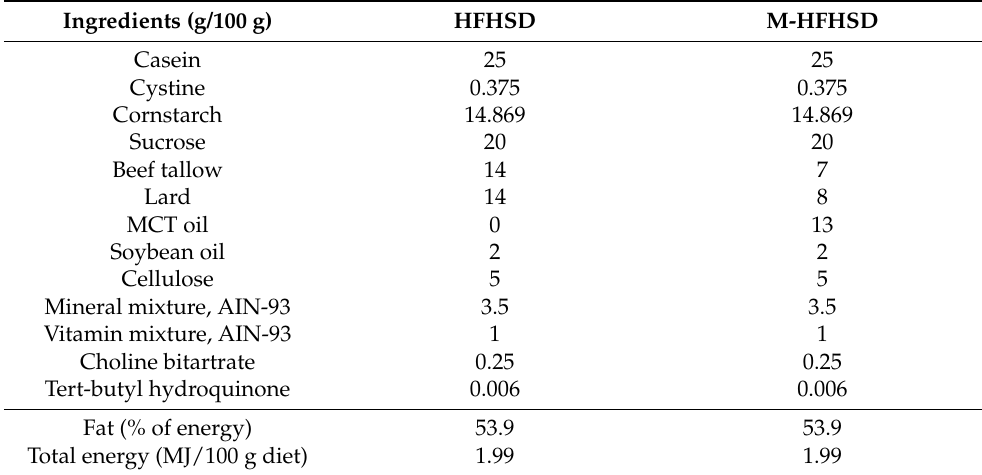
Table 1. Composition of the